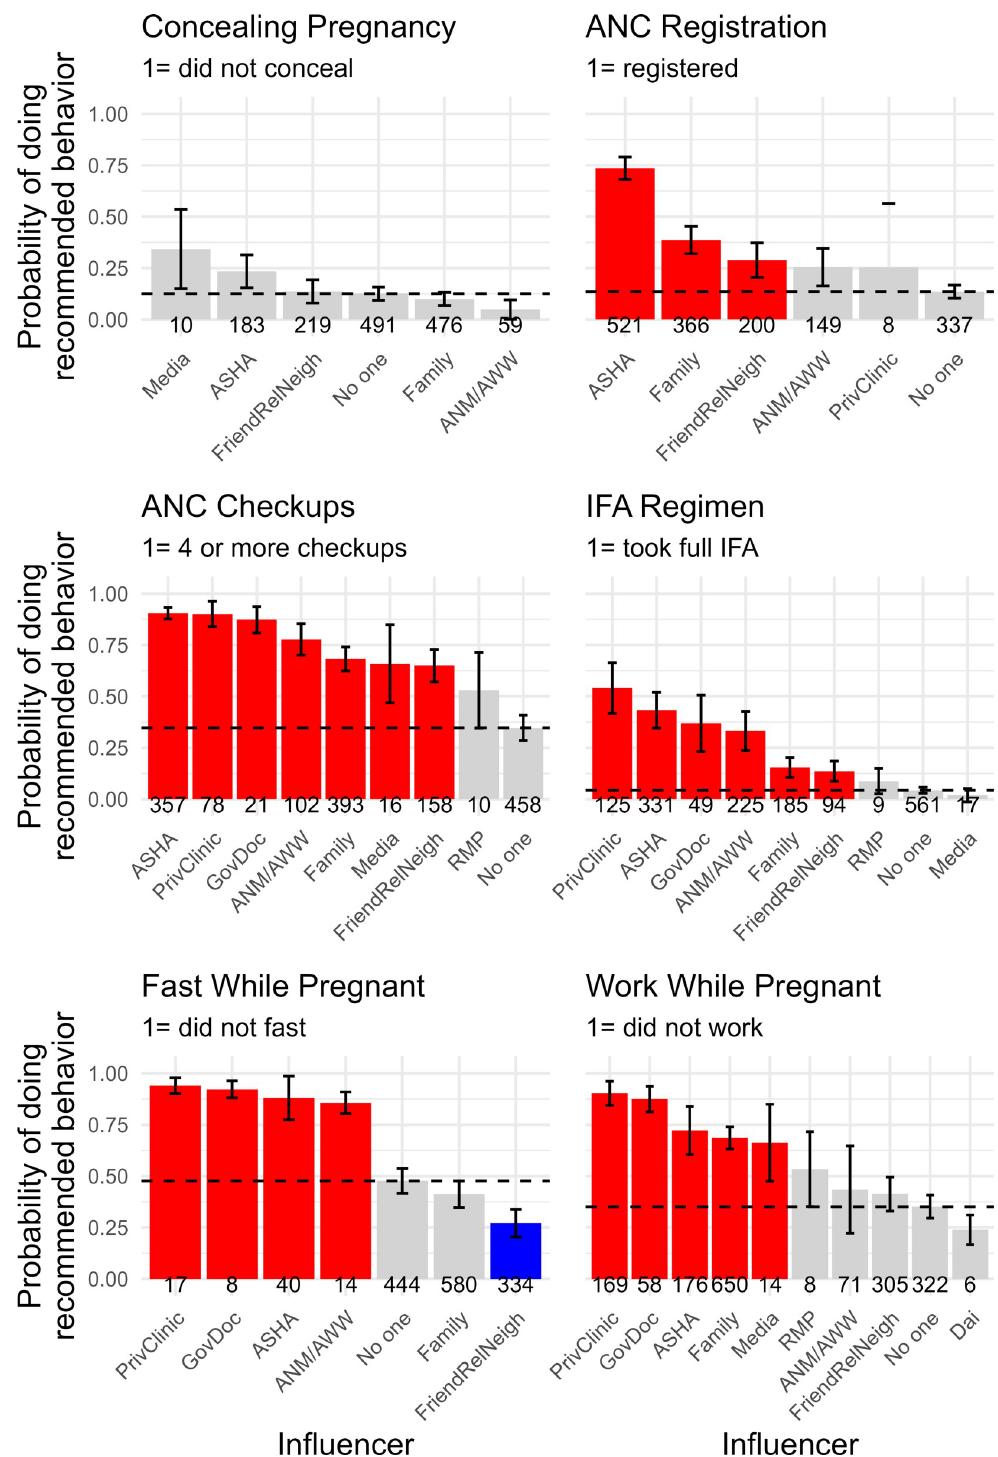
Fig 5. Predicted probabilities for each behavior during pregnancy. Red bars are positive effects (confidence intervals that are above and do not overlap with the reference category of no one). Grey bars are effects similar to no one (confidence intervals overlap). Blue bars are negative effects, meaning the influencer lowers the probability that the woman practices the recommended behavior compared to the reference category of no one. The thin black dashed line is drawn at the predicted probability of the reference category, ‘no